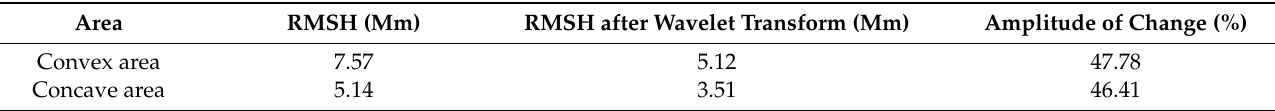
Table 4. Statistical analysis of RR before and after concave and convex wavelet